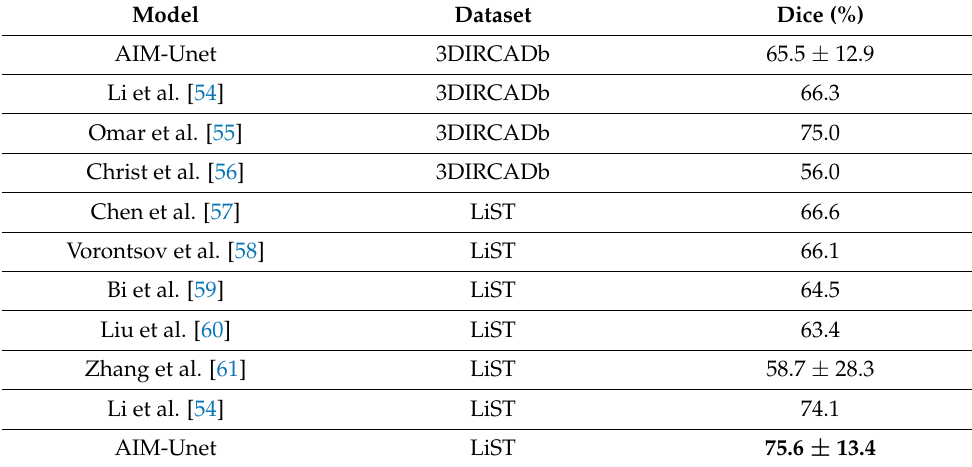
Table 6. The comparison of the proposed method (AIM-Unet) with other state-of-the-art architectures on datasets for tumor